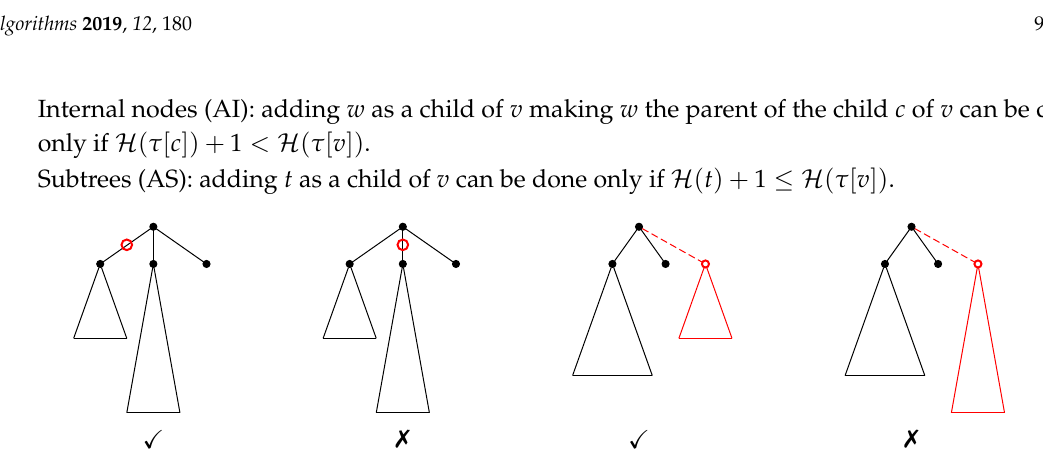
Figure 7. Allowed ( (cid:88) ) and forbidden ( (cid:55) ) inserting operations to construct the NEST of a tree. Deleting operations (see Figure 8)